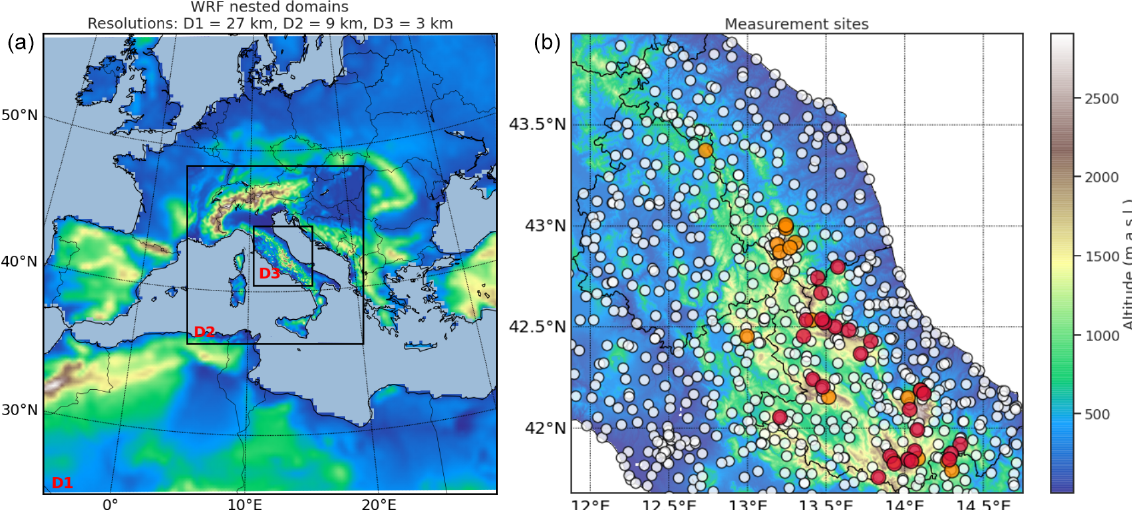
Figure 1. (a) WRF nested domains D1, D2 and D3 with resolution 27, 9, and 3km, respectively. (b) Atmospheric and snow measurement site locations in the D3 domain. The white circles represent automatic weather stations without a snow height sensor, while orange and red circles represent automatic weather stations with a snow height sensor and manual measurement sites, respectively. Table 1. Number of stations and observations for each of the analyzed variables at different elevation bands for the three snow seasons. Number of stations – observations